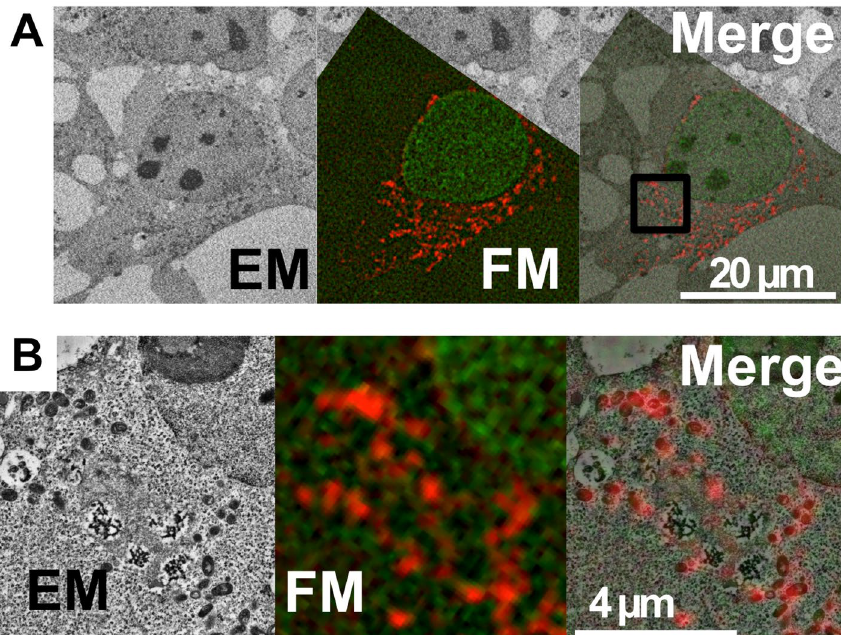
Figure 2. Two-color in-resin CLEM of nucleus and mitochondria was performed using H2B-CoGFPv0 and mCherry2-mito. Thin section (100 nm) of Epon-embedded cells expressing H2B-CoGFPv0 (green pseudo color) and mCherry2-mito (red pseudo color) was prepared. Fluorescent images (FM) were obtained in the presence of a TUK solution for multicolor with a BZ-X810 fluorescence microscope (CCD monochrome camera, NIKON CFI plan Apochromat 100 × Oil lens, gain + 16 dB, haze reduction) using filter sets for green and red fluorescent probes. Electron microscopic images (EM) were obtained with a Helios NanoLab 660 scanning electron microscope (a backscattered electron detector at a voltage of 2.0 kV with a current of 0.4 nA), and were processed with a method called “Contrast Limited Adaptive Histogram Equalization” using imageJ software with the plugin Enhance Local Contrast (CLAHE). The “Merge” is a merged image of the fluorescence image (FM) with an electron microscopic image (EM). The images in ( B ) indicate magnification of images corresponding to the boxed area in the Merge image in ( A